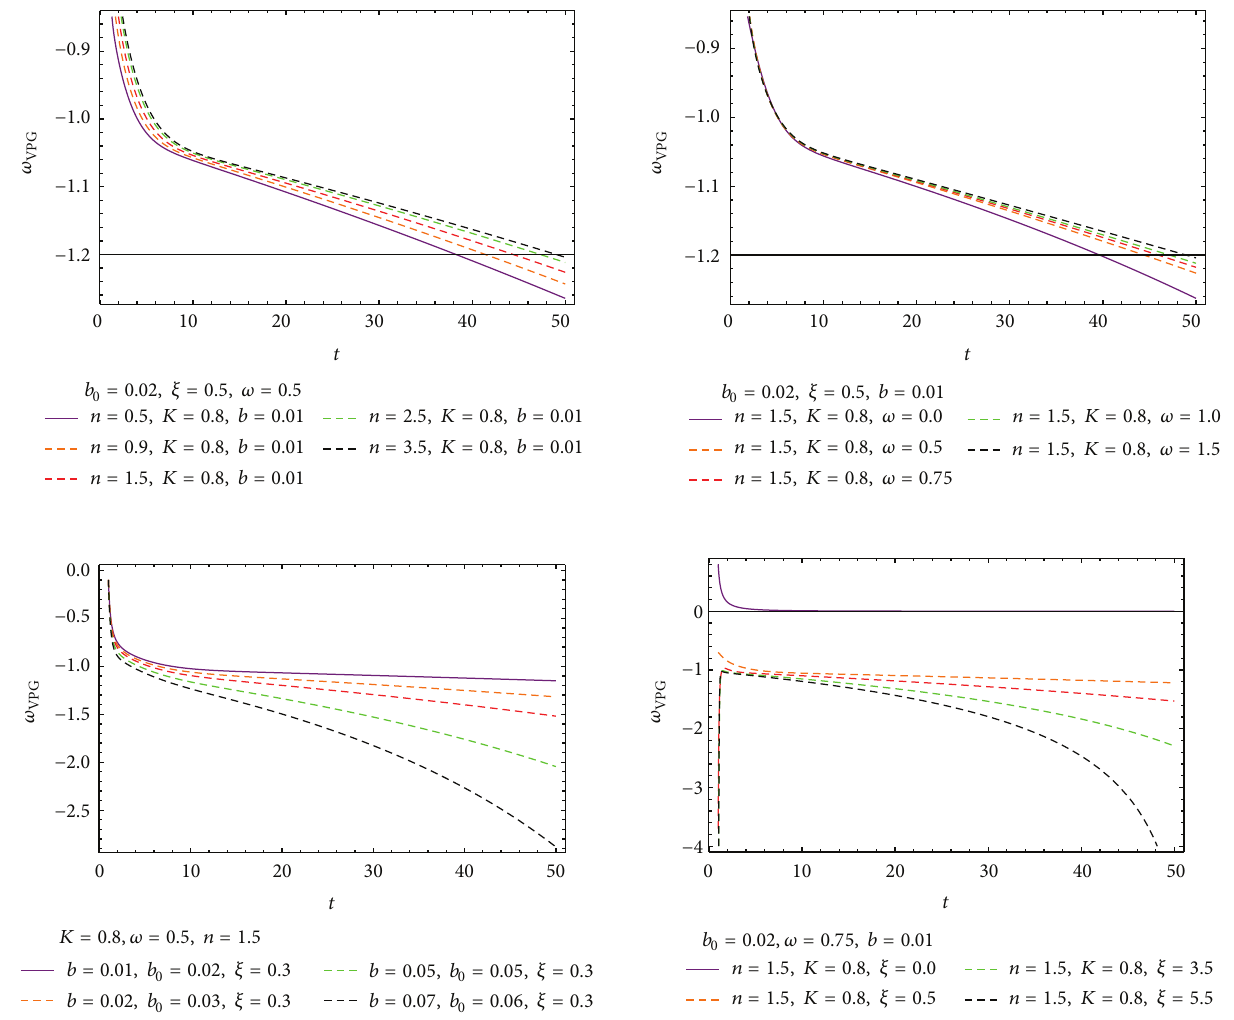
Figure 10: Behavior of EoS parameter of viscous polytropic 𝜔